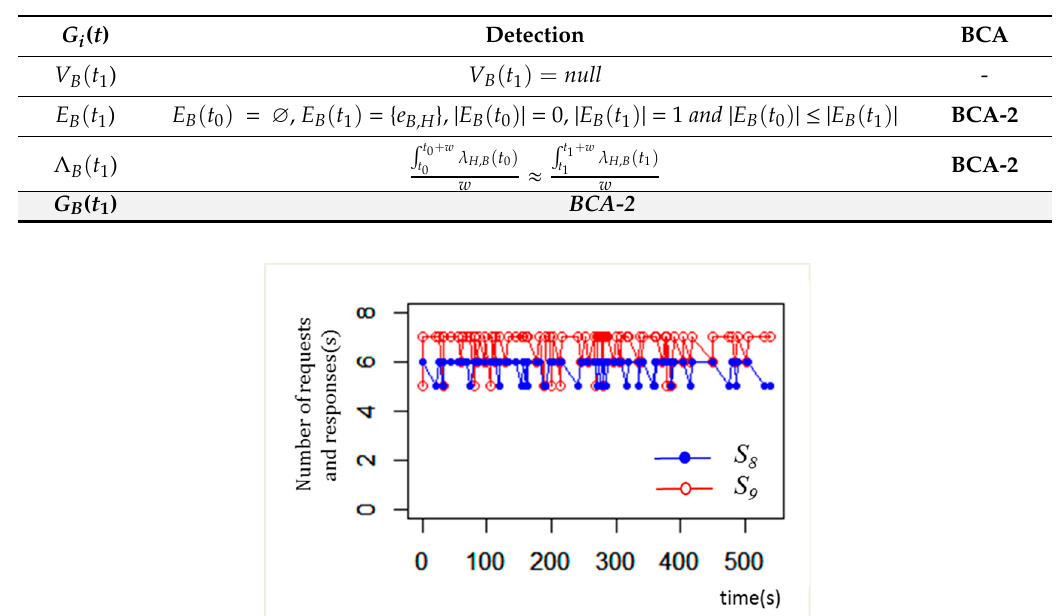
Table 10. BCA-2 detection on host B at t 1 during a password attack.